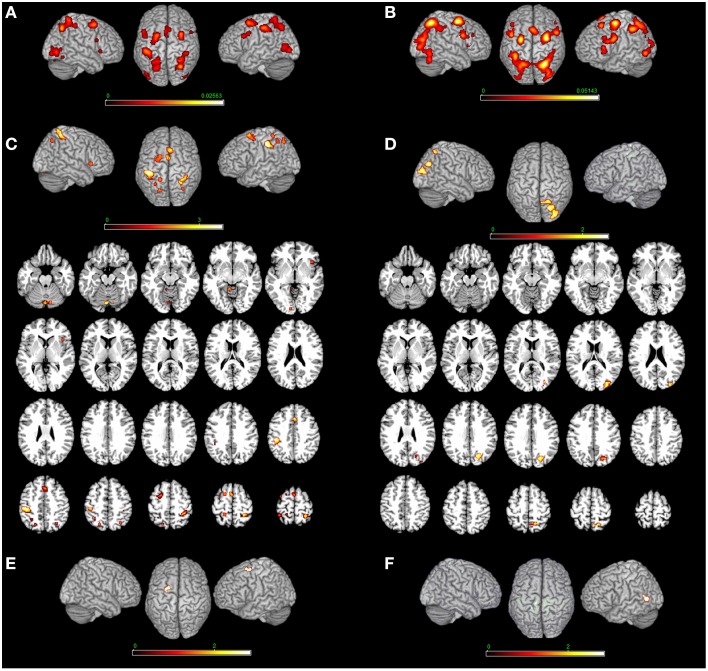
Bottom-up modulation of the MR network exerted by the type of stimulus. Bodily- (A) and non-bodily (B) stimulus. (C) Shows the direct contrast bodily> non-bodily stimulus and (D) shows the contrast non-bodily—bodily stimulus. For bodily related stimuli, in (E) we report MR of hands > body and in (F) we report MR of body—hands. Relative increases in neural activity associated with MR induced by different types of stimuli are displayed on a rendered template brain provided by spm5. Activations are significant at p < 0.05 corrected for multiple comparisons using the False Discovery Rate (FDR). In (A,B) color bar shows ALE value, in (C–F) color bar shows Z maps. The Z coordinates for each slices range from −24 to 66 (with incremental steps of 5 mm).